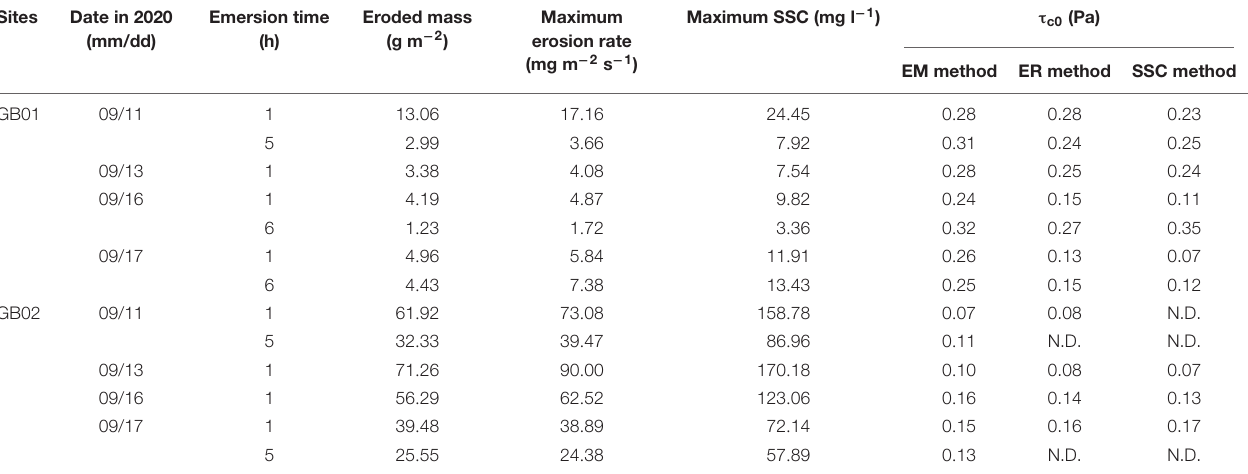
TABLE 1 | Results of erosion microcosm experiments. Sites